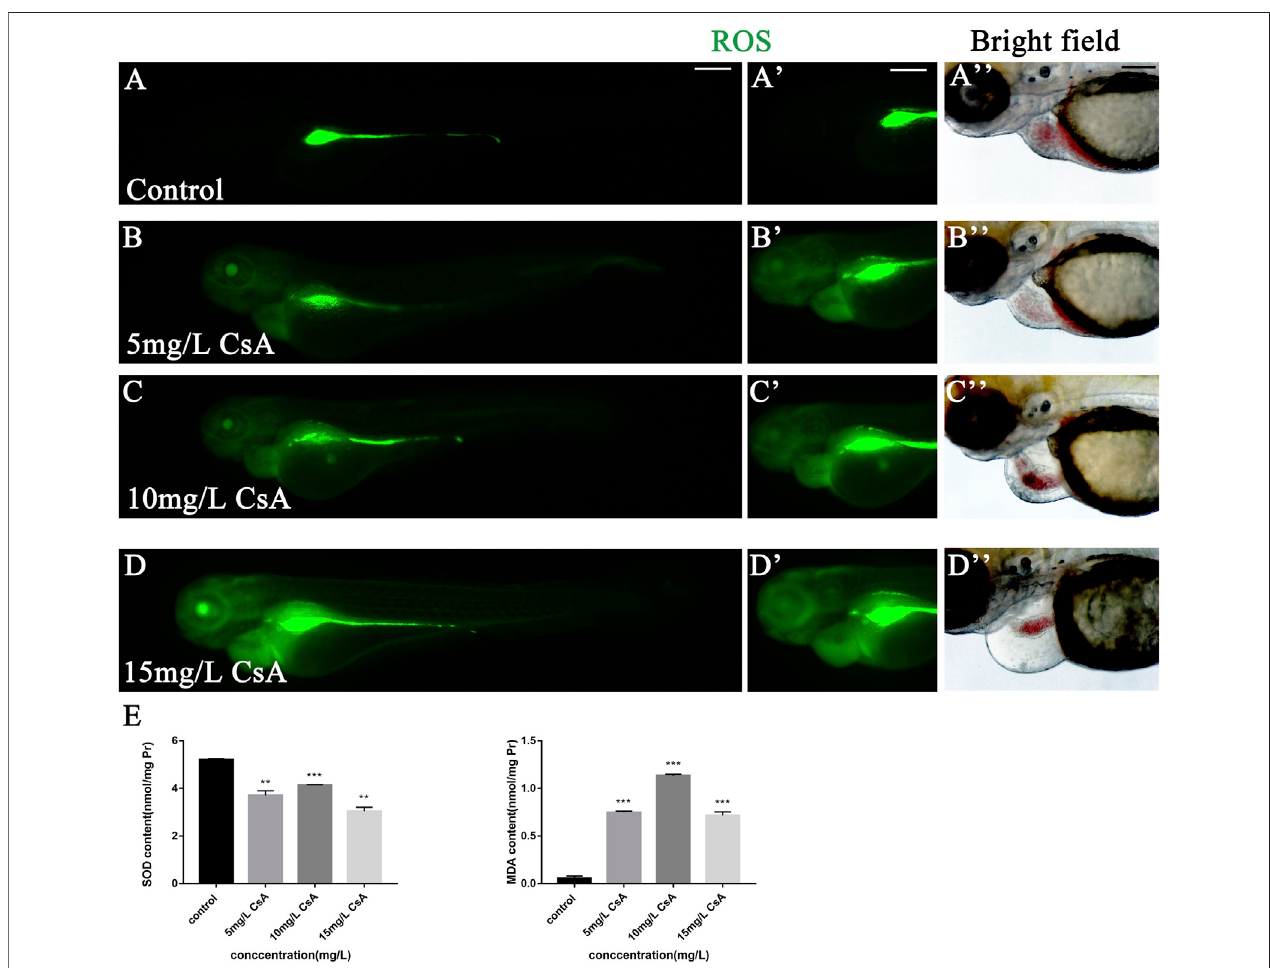
FIGURE 5 | The accumulation of oxidative stress in zebra fi sh induced by CsA. (A-D) ROS staining of heart of zebra fi sh embryos at 72 hpf exposed to 5 mg/L, 10 mg/L, and 15 mg/L CsA. TheROSstaining wasgreen. (E) The SODactivity and MDA contentofzebra fi sh at 72 hpf exposed to5 mg/L, 10 mg/L, and 15 mg/L CsA (Compared with control: ** p < 0.01, *** p < 0.001, mean ± S. D). Scale bars:100 µm (A-D) .